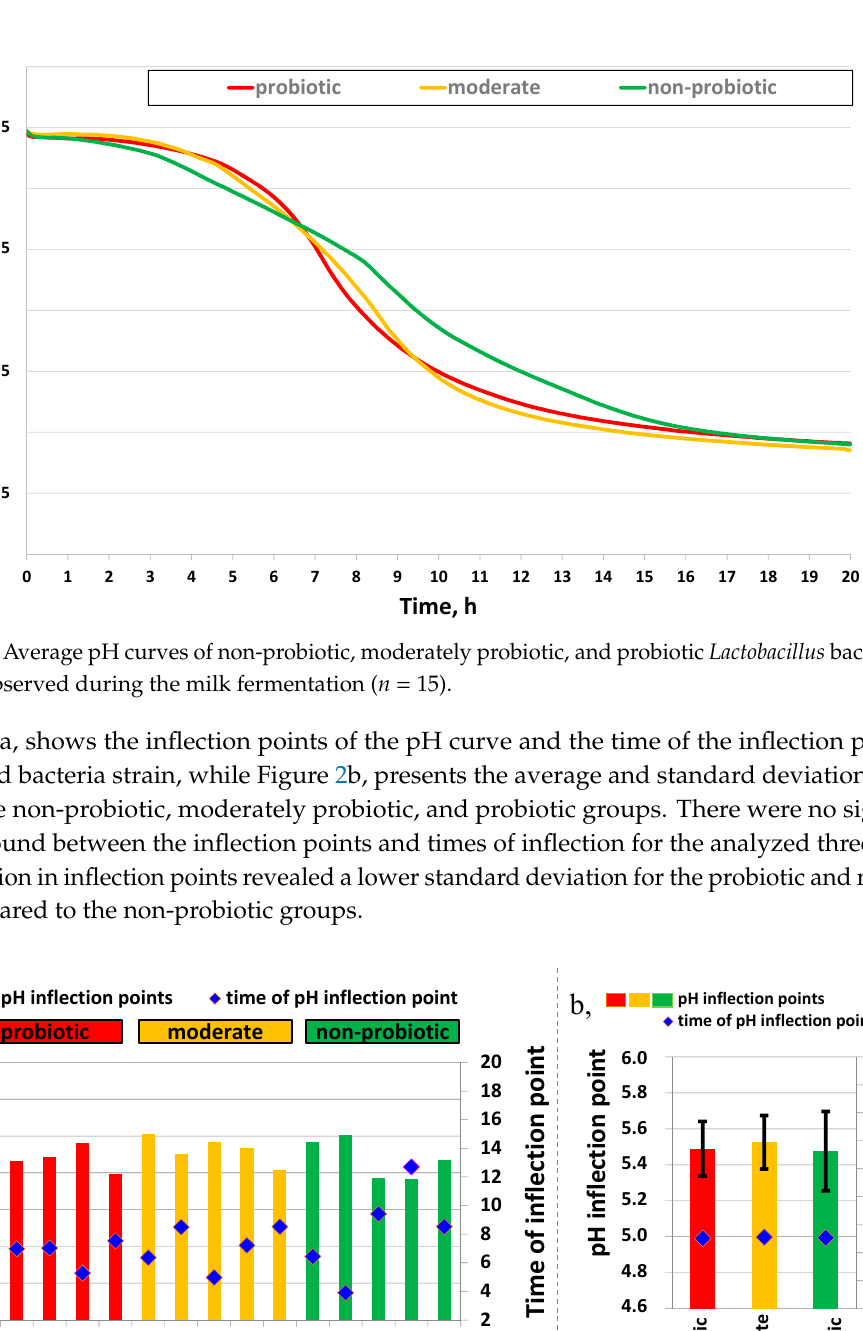
Figure 2. ( a ) , Inflection points and time of the inflection points of the pH curves of the tested Lactobacillus strains ( n = 15)and ( b ) , an average of the inflection points and time of the inflection points of the pH curves of the non-probiotic, moderately probiotic, and probiotic groups measured during milk fermentation ( n = 15).